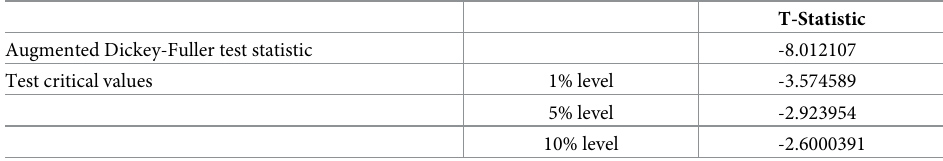
Table 4. Results of 1st order